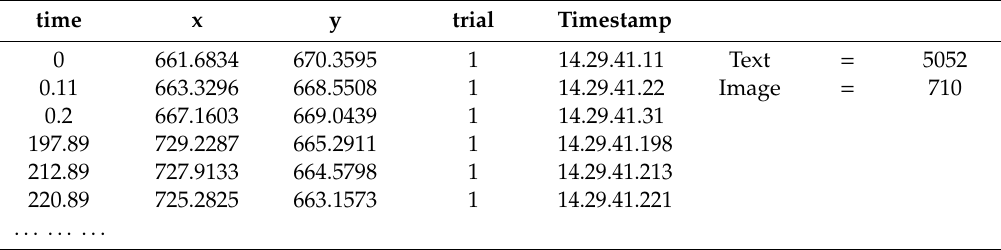
Table 3. gaze ratio and gaze